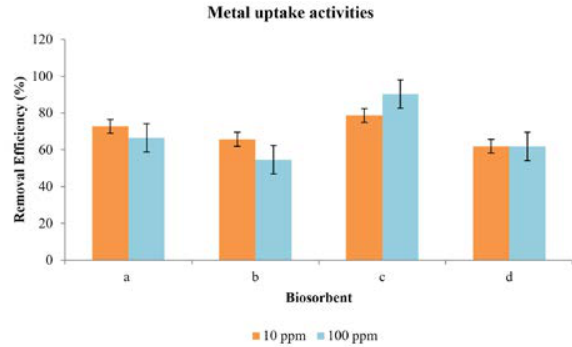
Fig. 8. Metal uptake activities by (a) dead cells of A. niger, (b) live cells of A. niger, (c) dead cells of R. oryzae and (d) live cells of R. oryzae